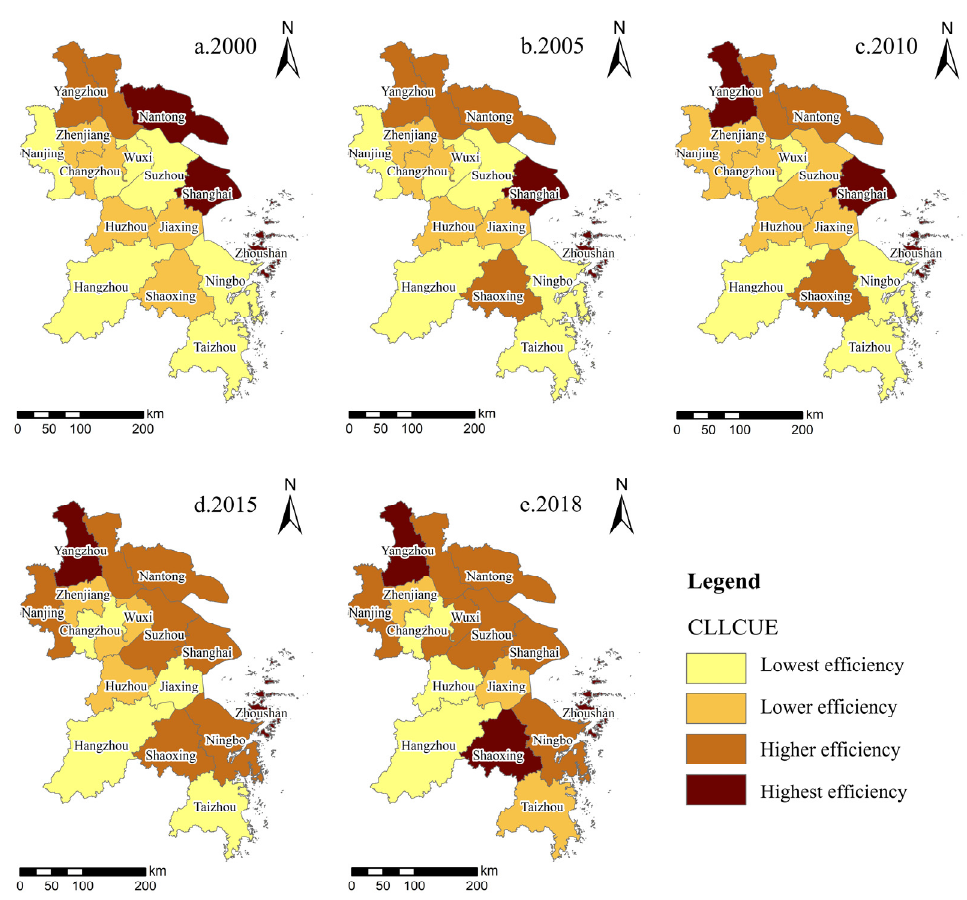
Figure 7. The spatial pattern of cultivated land low-carbon utilization efficiency of the Yangtze River Delta during 2000–2018.